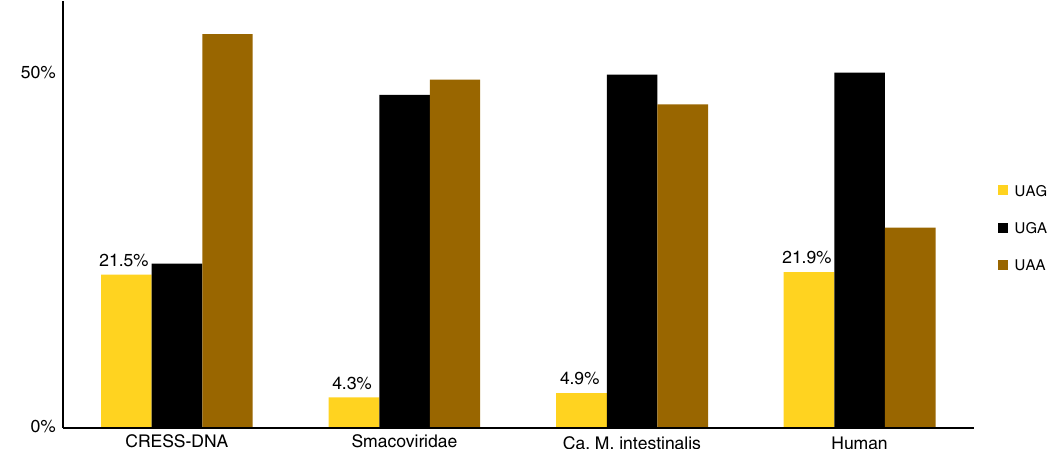
Fig. 3 Stop codons usage of Smacoviridae compared to Circular Rep Encoding Single-Stranded DNA (CRESS-DNA) viruses and possible hosts. In organisms, such as Candidatus M. intestinalis, that use amber (UAG) codon to codify pyrrolysine, its use for translation termination is reduced. Bars represent the percentage of coding sequences ending in one of the standard termination codons that end with amber , opal (UGA) or ochre (UAA) codons for a set of CRESS-DNA virus, a set of smacoviruses, Ca . M. intestinalis genome and human genome (see details in Methods section). Only percentages of amber codon are